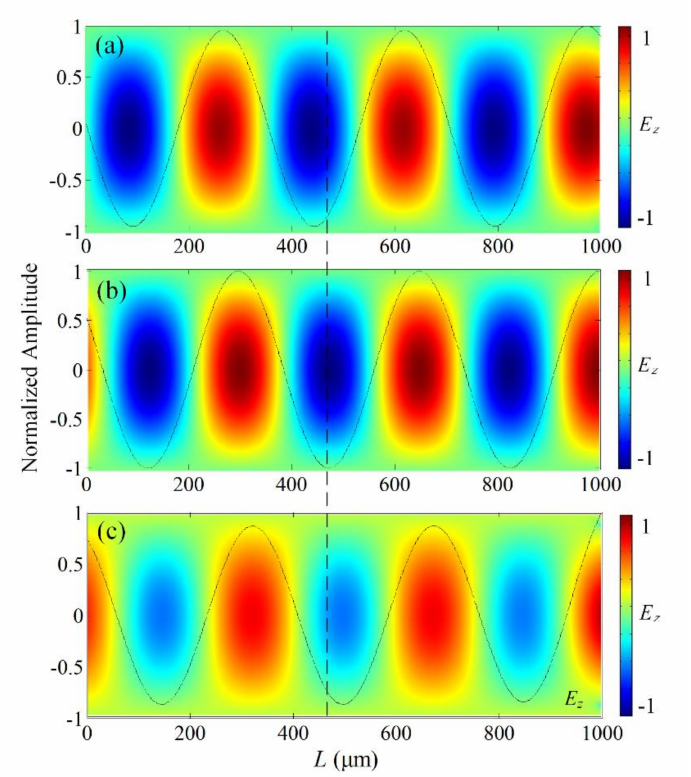
Figure 2. E z components of reflected electric fields at 1.027 THz for ( a ) Waveguide A, ( b ) the perfect electrical boundary, and ( c ) Waveguide B. The reflected phase of Waveguide A is delayed while that of Waveguide B is advanced relative to the THz waves reflected by the perfect electrical